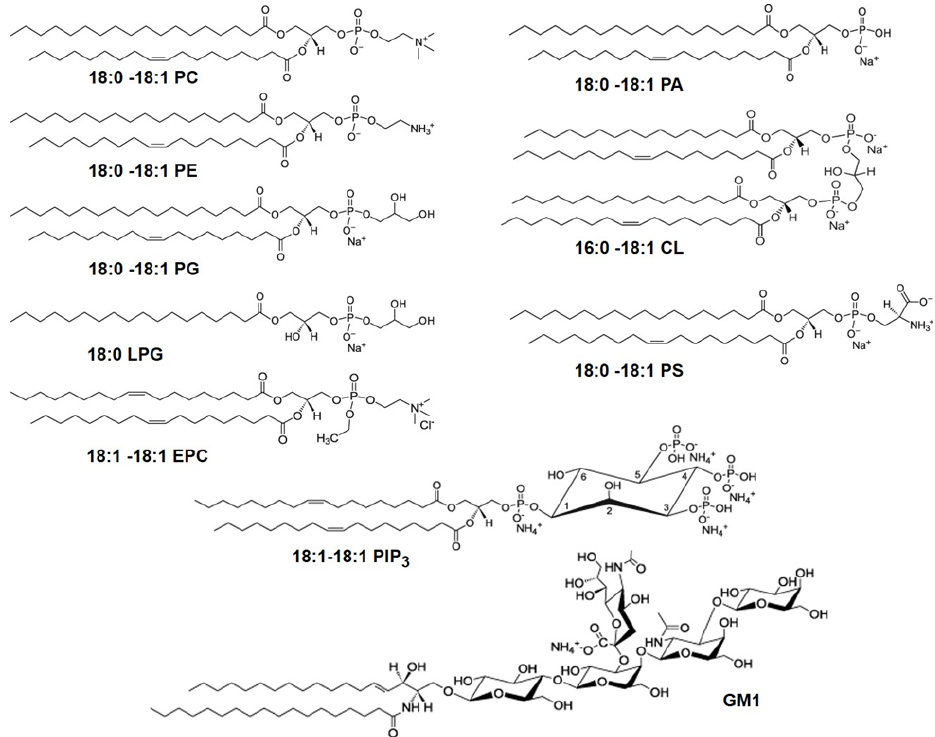
Figure 3. Molecular structures of glycerophospholipids with different head groups referenced in this paper. The numbers designate the chain length and the number of unsaturated bonds in the fatty acid chains of the lipids. The glycerophospholipids with different head groups shown here include: phosphatidylcholine (PC), phosphatidylethanolamine (PE), phosphatidylglycerol (PG), phosphatidylserine (PS), phosphatidic acid (PA), ethyl phosphatidylcholine (EPC), phosphatidylin- ositol triphosphate (PIP 3 ), all with two acyl chains, lysophosphatidylglycerol (LPG) with a single acyl tail and cardiolipin (CL) which has two phosphatidic acid moieties connected via a glycerol backbone forming a dimeric structure, with four acyl chains. Also shown is the glycosphingolipid, monosialoganglioside (GM1) which has a sphingosine and fatty acid chains connected to a branched pentasaccharide head group with a terminal sialyl residue.